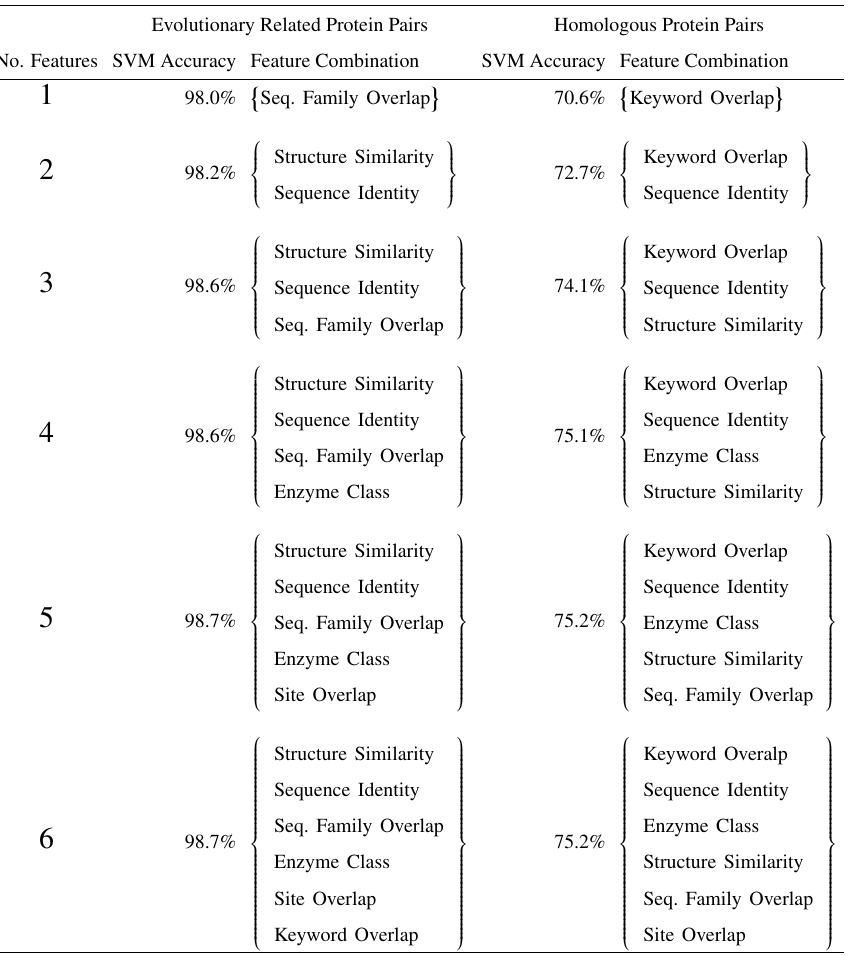
Table 4: Search for combinations of features that maximize discrimination for the problems of detecting pairs of evolutionarily related proteins and homologous